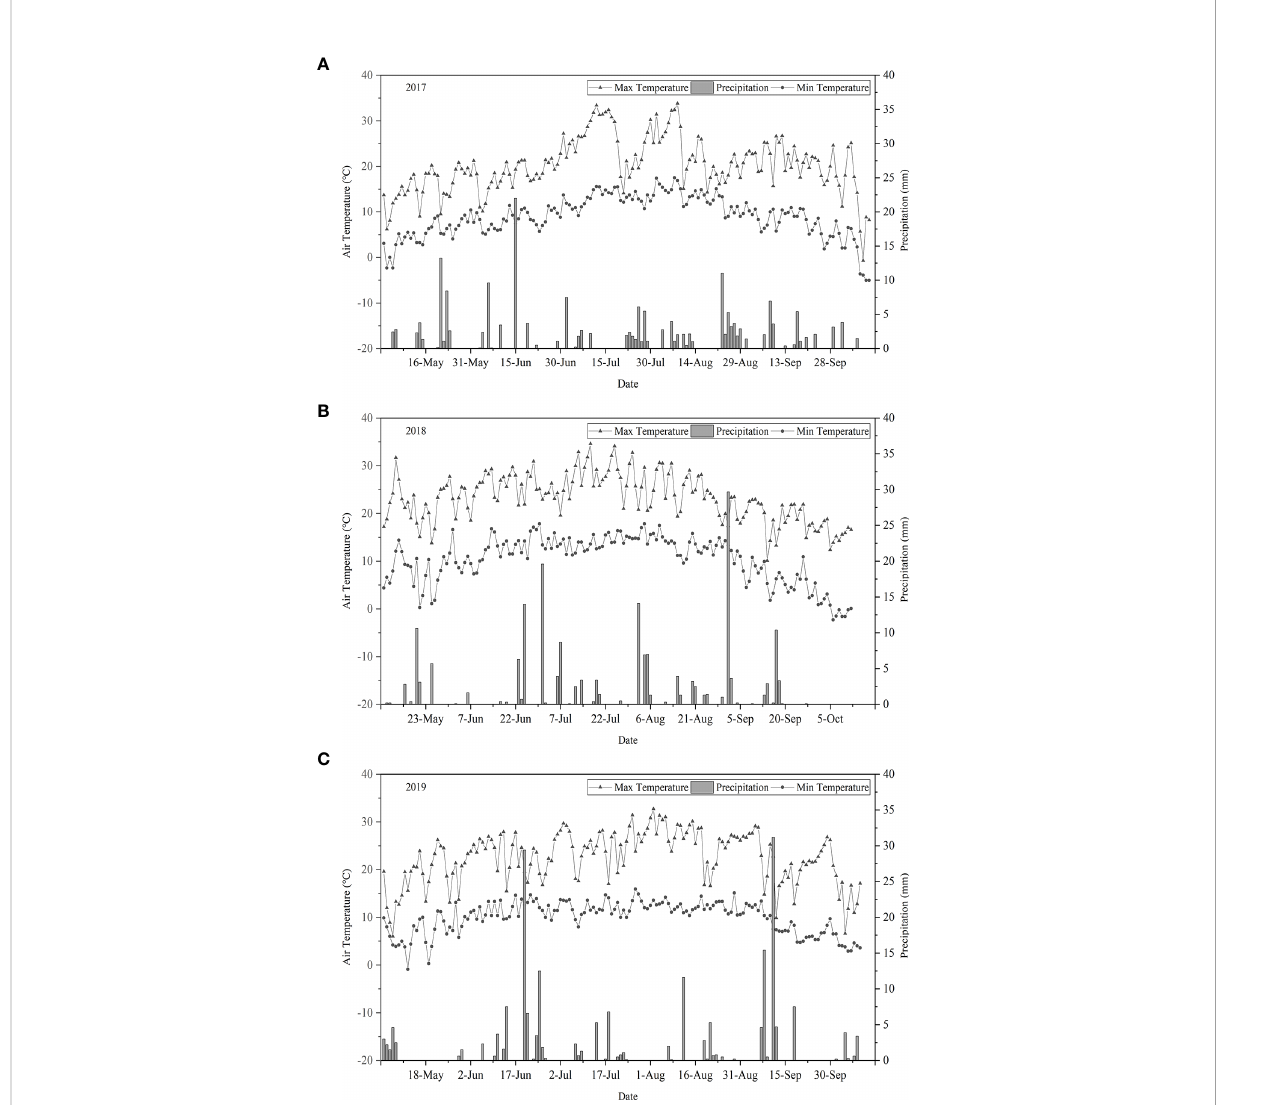
FIGURE 2 Daily maximum and minimum temperature and precipitation data during the growth period of I. indigotica in 2017 (A) , 2018 (B) , and 2019 (C) .